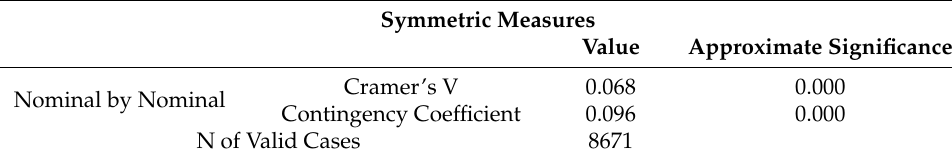
Table 20. Strength of dependence between variables. Source: own research.